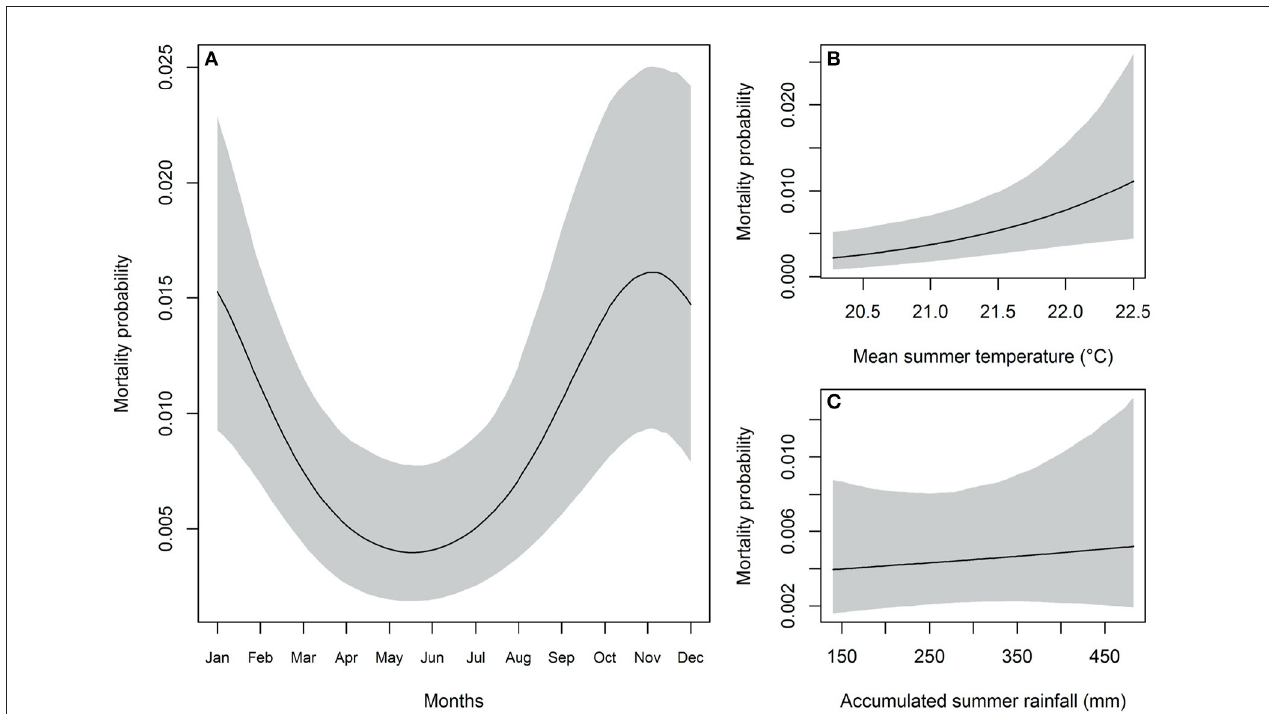
FIGURE 4 | (A) Estimated seasonal effect of the P. tenuis -induced mortality probability within the year (parameters K o , E and R ). Environmental effect of mean summer temperature [ (B) ; parameter β 1 ] and accumulated summer rainfall [ (C) ; parameter β 2 ] on the among-year variability of the probability of P. tenuis -induced mortality (parameter K y